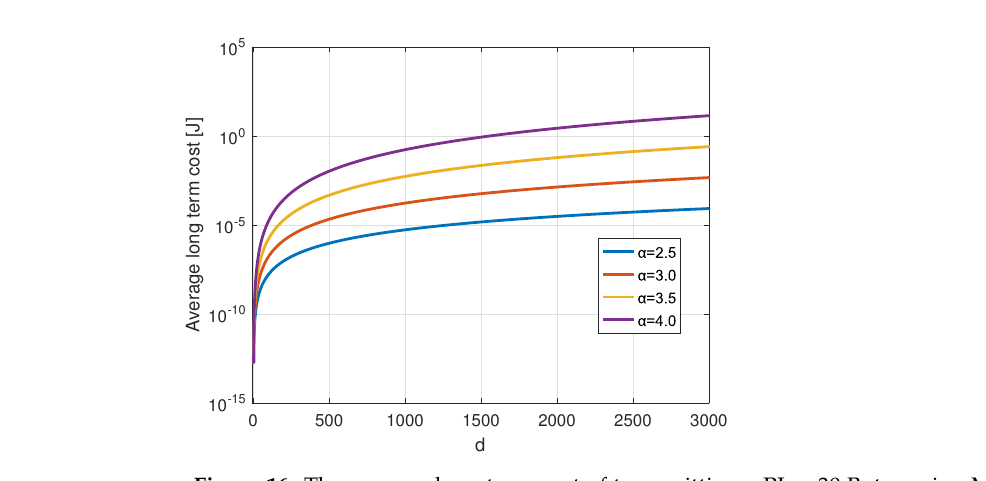
Figure 16. The average long term cost of transmitting a PL = 30 Bytes using MDP method under different channel states versus distances.